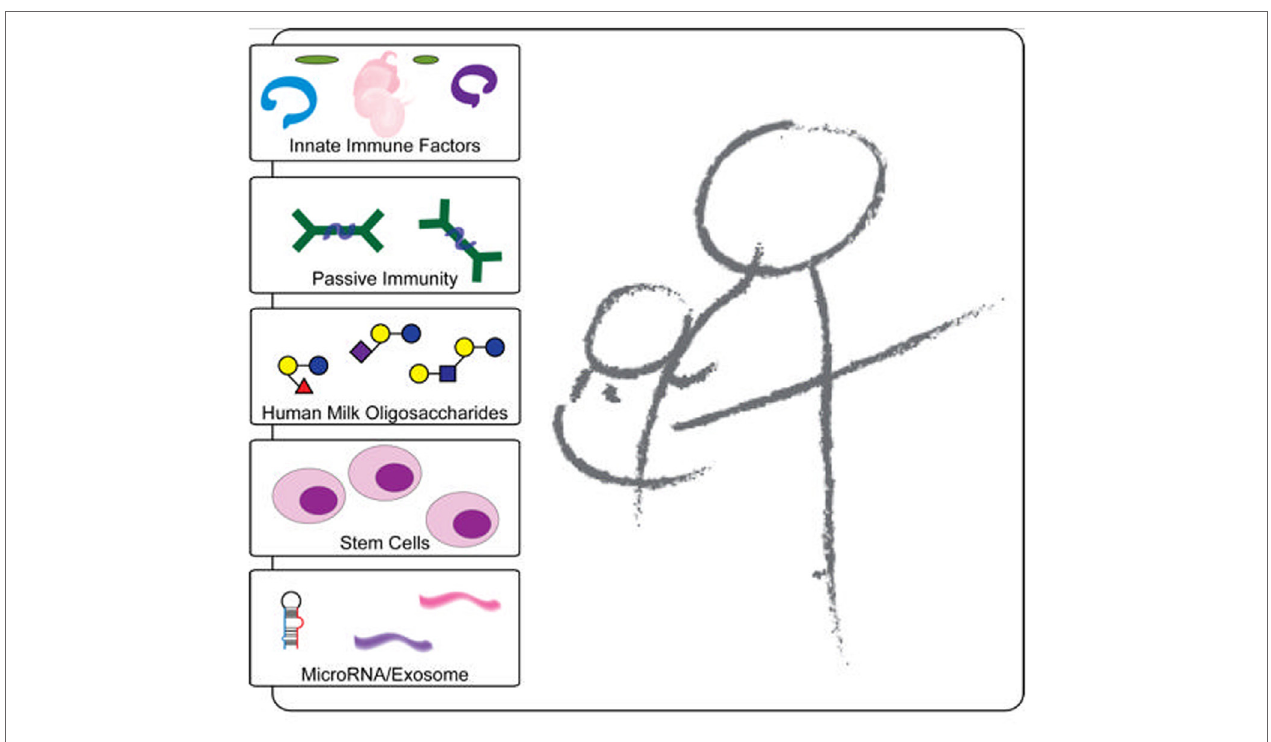
FiGURe 1 | Schematic representation of the protective components in breast milk. Breast milk innate factors that have anti-inflammatory and antimicrobial properties are likely to affect the passage of HIV through the breastfeeding infant’s intestine by modulating the integrity of the intestinal mucosa and directly inactivating the virus. In contrast to exclusively breastfed infants, non-exclusively breastfed infants may be exposed to contaminated water and/or food antigens without a protective threshold level of innate factors in breast milk, which may lead to increased intestinal permeability and microbial translocation. In addition, the foreign antigens likely increase inflammation and recruit increased target cells leading to increased HIV